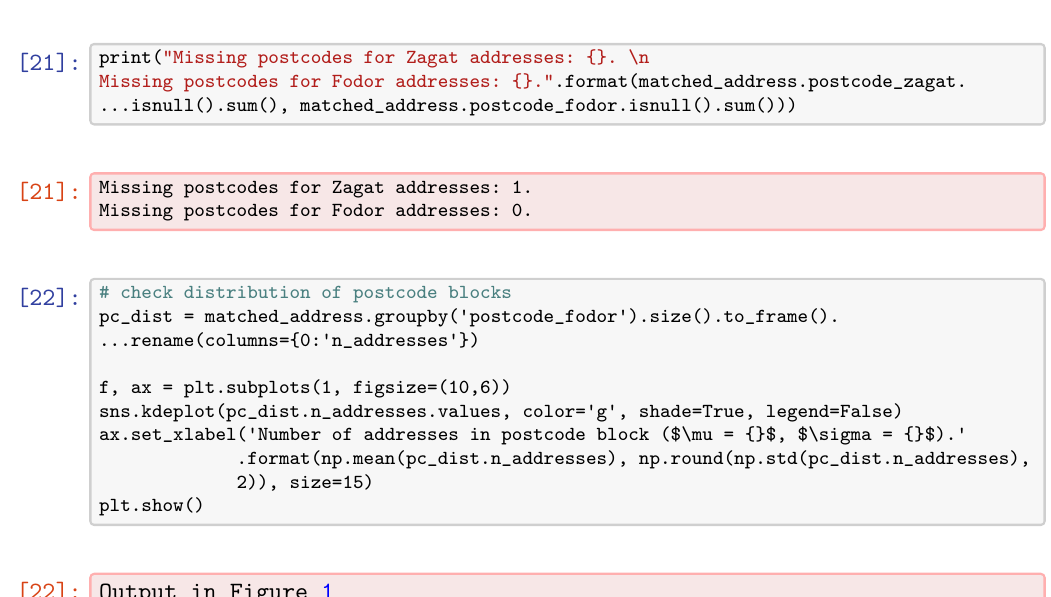
Figure 1: Figure generated by code